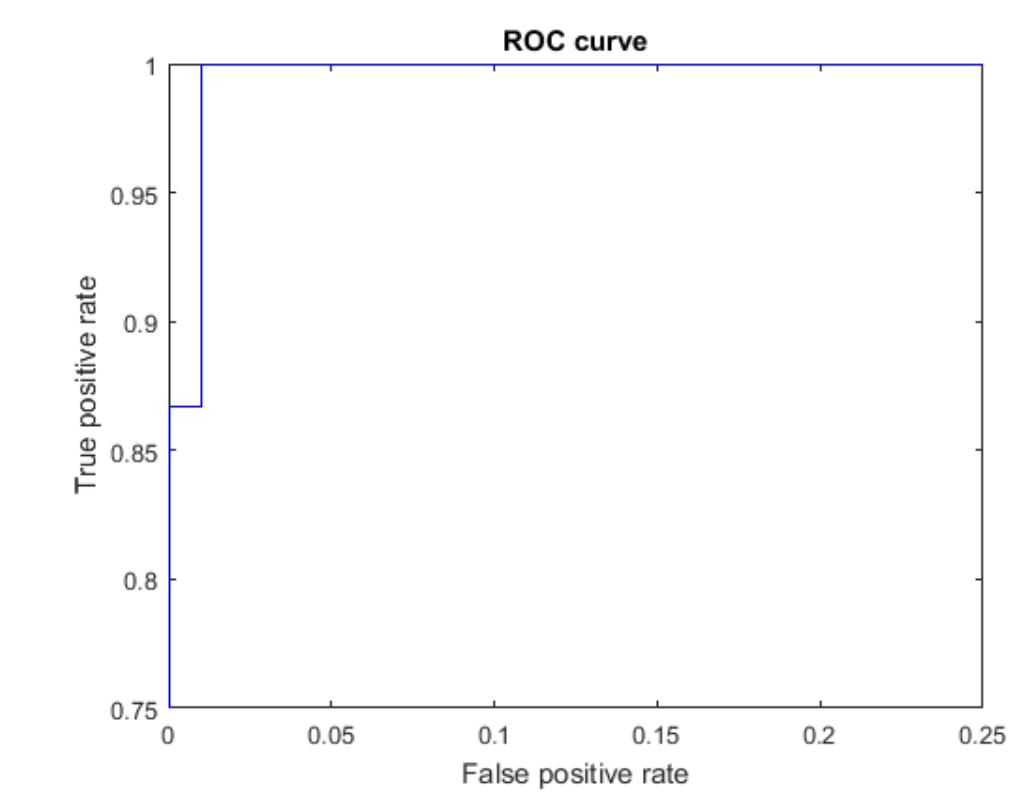
Figure 8. ROC curve for the letter M using spherical features, AUC = 0.9987.